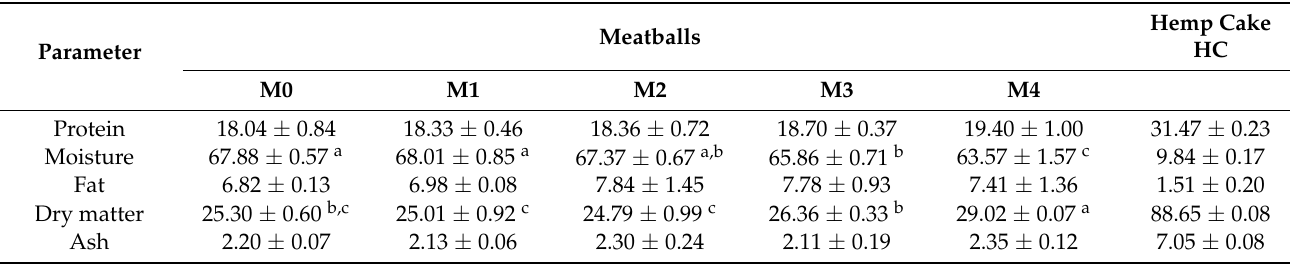
Table 2. Proximate composition of cooked meatballs and hemp cake; mean ±